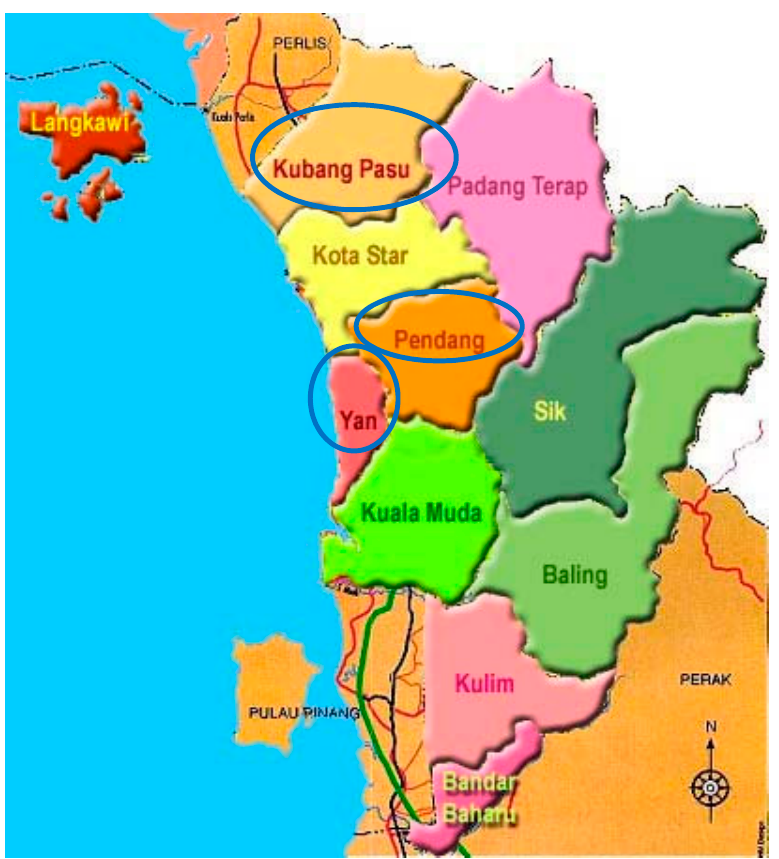
Figure 1. Map of sampling areas of paddy in Kedah, Malaysia Northern region.